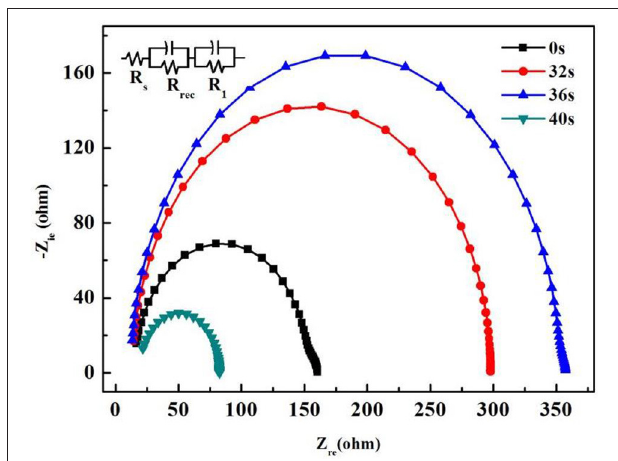
FIGURE 5 | Nyquist plots of the PCBM/Ag and PCBM/BCP/Ag based PSCs at 0.7V bias under dark (The inset shows the equivalent electronic circuit used to fit the experimental data).